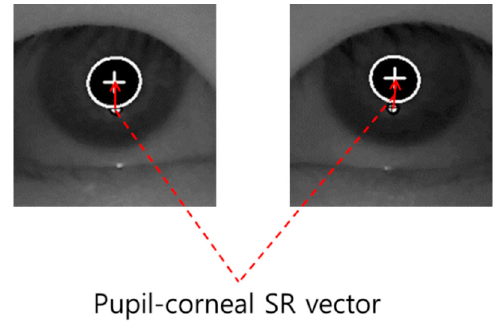
Figure 2. Example of pupil-corneal SR vector.